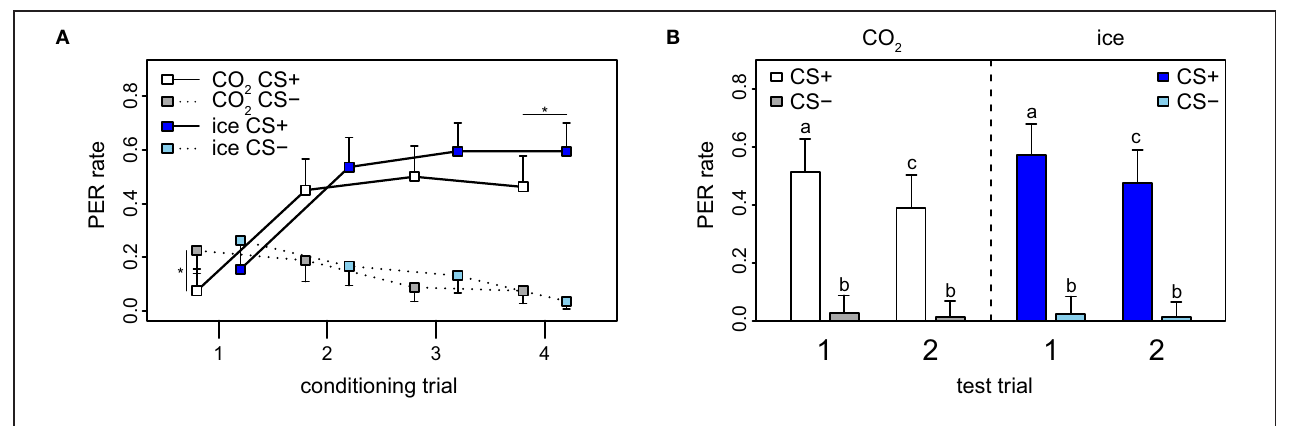
FIGURE A9 | Effect of anesthesia on conditioning and recall in PER. (A) PER data stratified by anesthesia (CO 2 and ice). The PER response was significantly lower for CO 2 -treated than for ice-treated bees for the last trial ( p = 0 . 045, χ 2 = 4 . 0, df = 1). Error bars indicate 95% confidence intervals and asterisks indicate